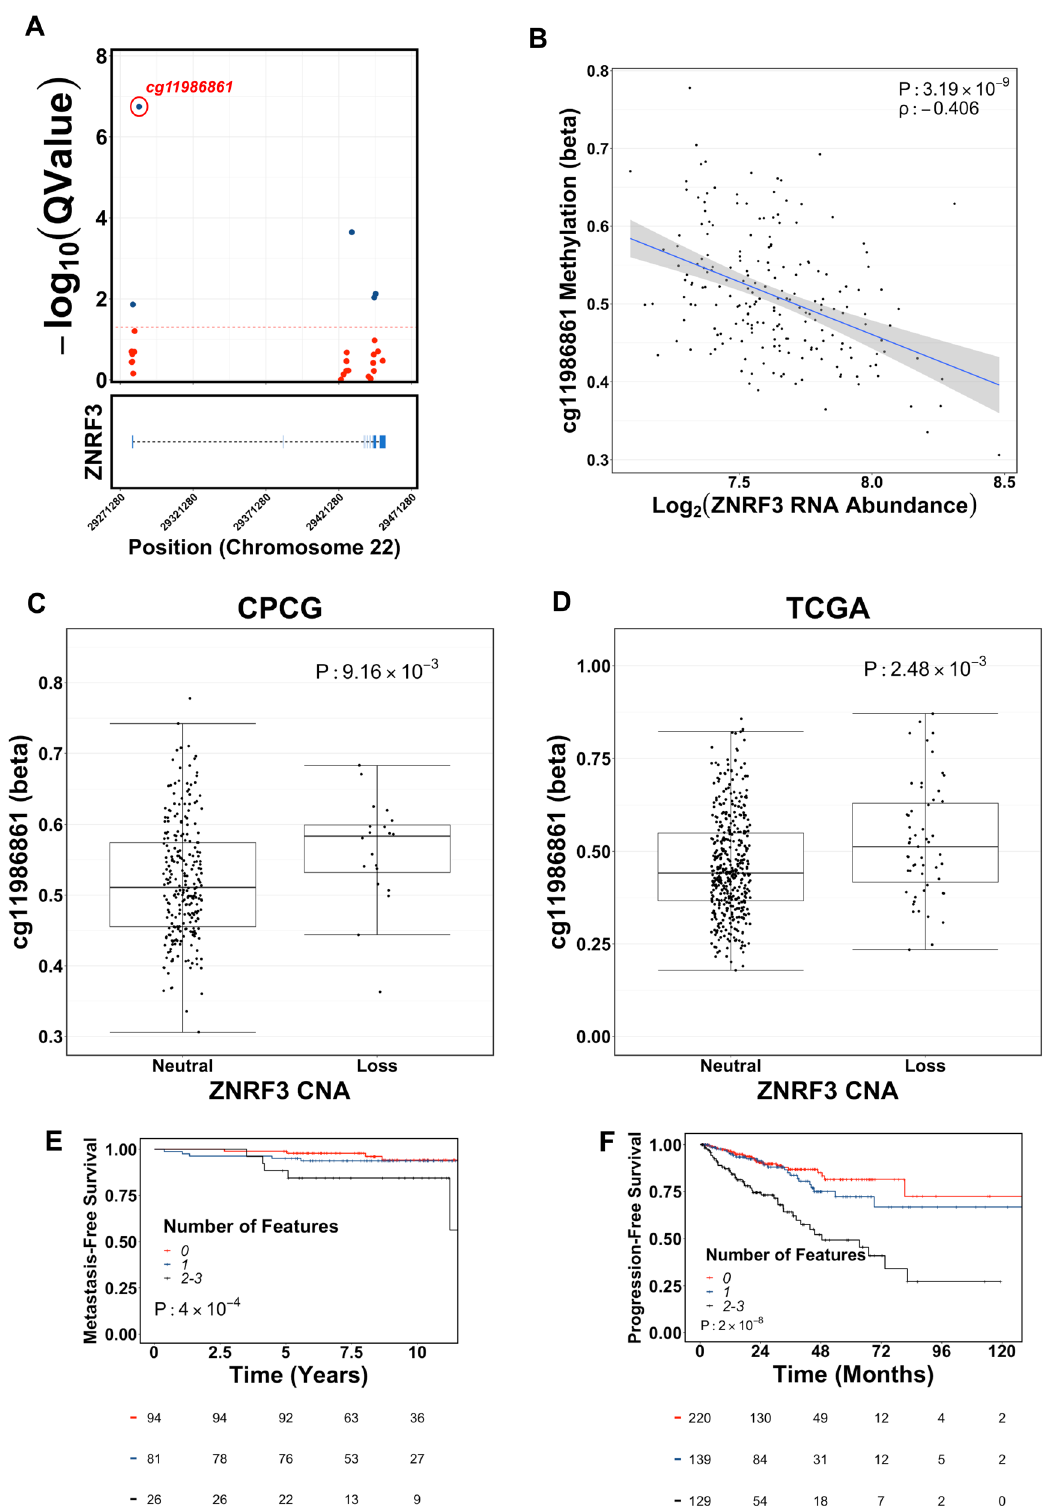
initially focused on TCGA cases to capitalize on the larger number of samples with RNA abundance data ( n = 493). GSEA of Gene Ontology (GO) pathways revealed enrichment of cell cycle progression gene sets in tumors harboring ZNRF3 loss (Fig. 5B), which validated in two independent cohorts of both localized and metastatic prostate cancer (Fig. S12A, B). Given the enrichment of cell cycle progression gene sets in